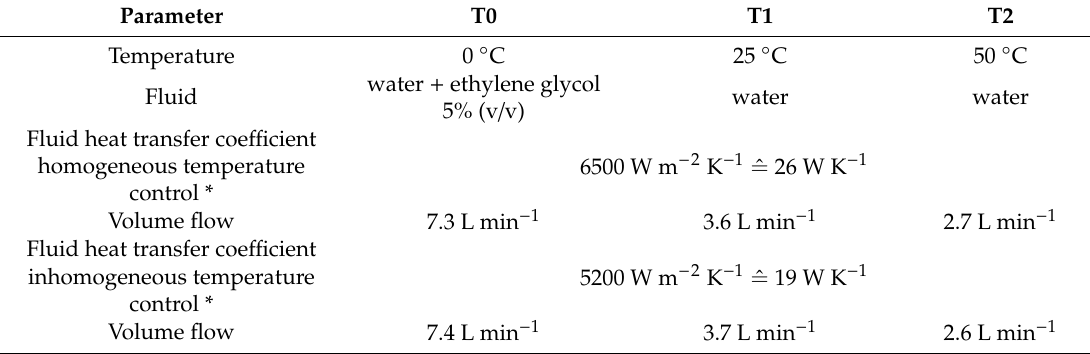
Table 2. Target parameters of cooling and heating